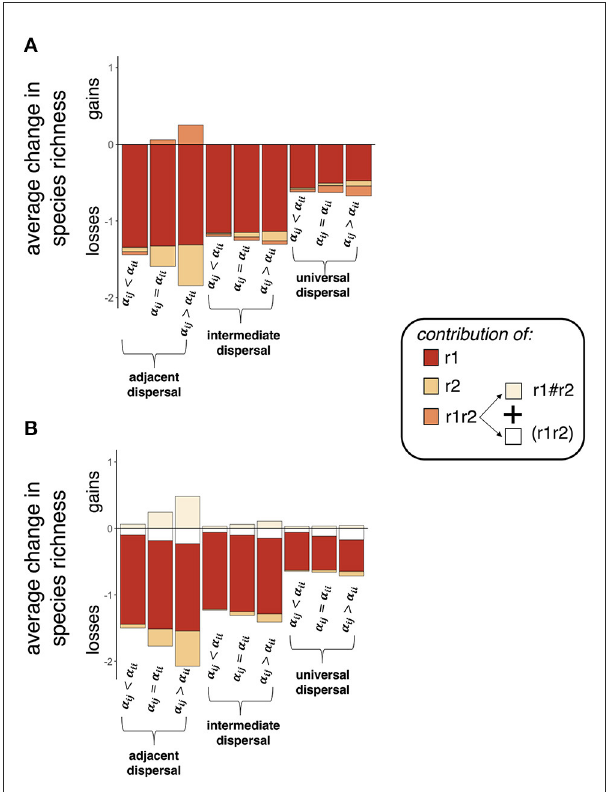
FIGURE6 Abiotic effects on density (route 1) and interaction strengths (route 2) both led to species losses in small sampling units (5 x 5 microsites). Contributions from route 1, r1, were generally larger than contributions from route 2, r2. In (A) , we can see that contributions from the interaction between routes 1 and 2, r1r2, were usually small. In (B) , we can see this is because the uncorrelated (“r1#r2”) and correlated [“(r1r2)”] components of r1r2 had opposite effects on species richness. Specifically,